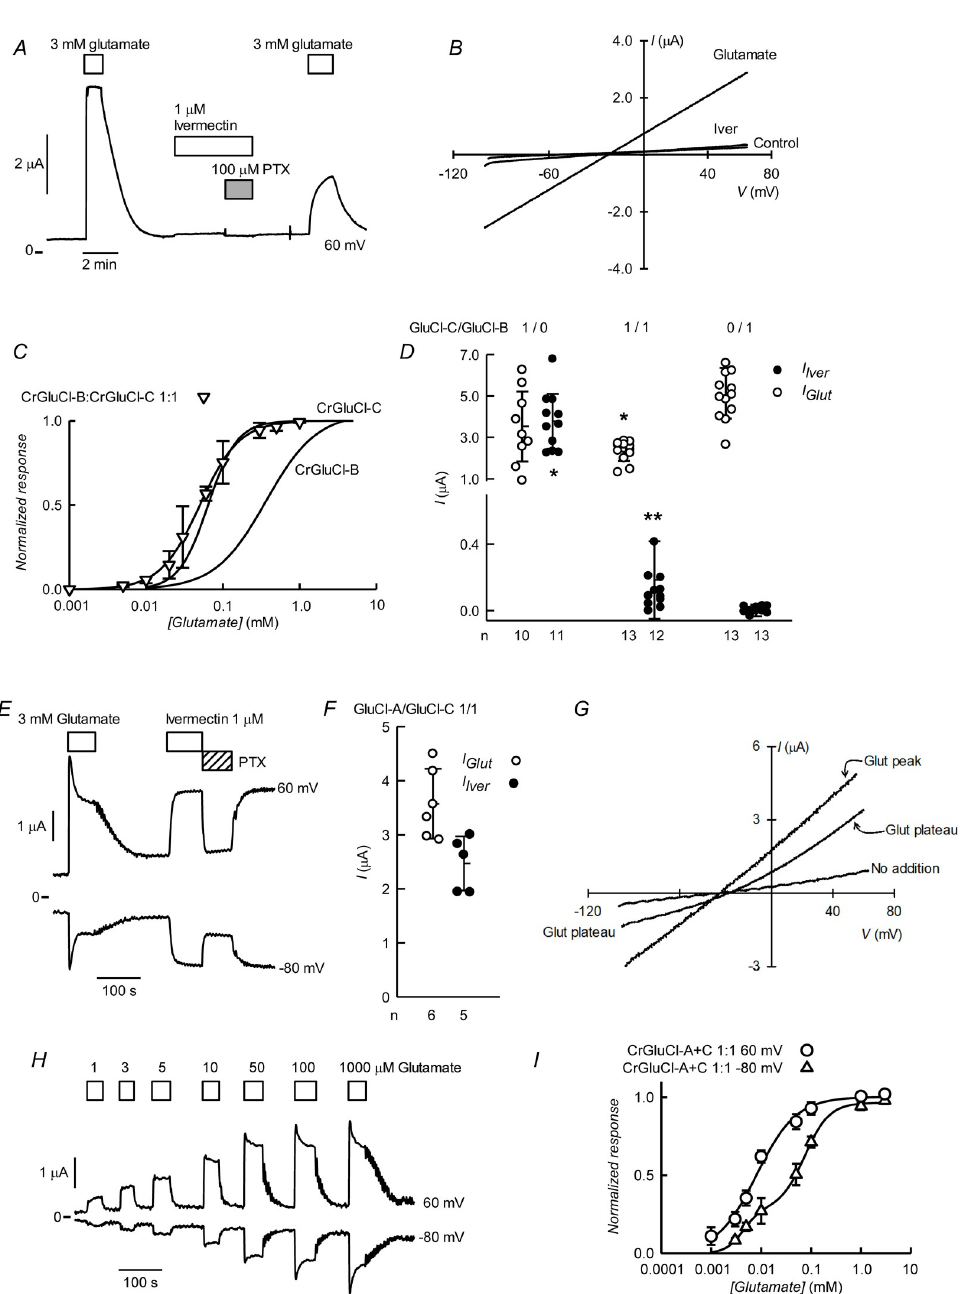
Fig 9. Functional properties of CrGluCl-C with CrGluCl-B, and CrGluCl-C with CrGluCl-A subunits after coinjection into Xenopus oocytes. A. Currents elicited by 3 mM glutamate or 1 μ M ivermectin in an oocyte expressing subunits C and B after microinjection of 10ng cRNA for each CrGluCl-C and CrGluCl-B. Recording taken at 60 mV. B. IV relations corresponding to control before any addition or during the glutamate (first addition) or ivermectin challenges. C. Dose-response relationship of the glutamate-sensitive currents of CrGluCl-C:CrGluCl-B mixed expression experiments. Data are normalized (mean ± SD, n = 13) to the maximal effect of glutamate. The line is a Hill equation fit. Those for subunits CrGluCl-B and CrGluCl-C expressed separately are taken from Figs 3B and 5B and are shown for comparison. D. Summary of currents elicited by glutamate or ivermectin in oocytes expressing CrGluCl-C or CrGluCl-B subunits on their own, or together in a 1:1 proportion. Total cRNA injected was always 20 ng. Data points report individual measurements with means ± SDs also shown, n indicated under the abscissa. Glutamate or ivermectin responses significantly different from those with CrGluCl-B alone are � P < 0.05 as analysed by Kruskal-Wallis one way ANOVA. �� P < 0.001 indicates value different from zero in a one-sample t-test. E. Currents elicited by 3 mM glutamate or 1 μ M ivermectin in an oocyte expressing subunits C and A after microinjection of 10ng cRNA for each CrGluCl-C